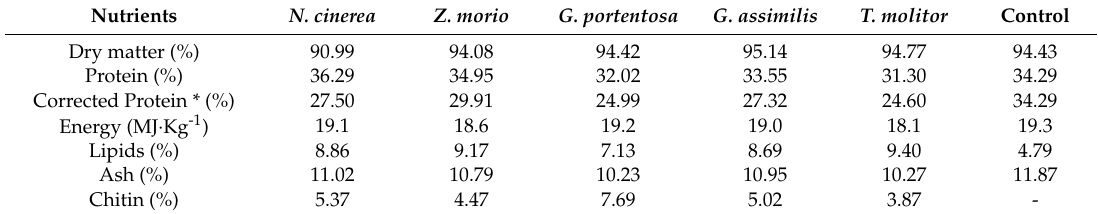
Table 2. Centesimal composition of the experimental diets (dry matter basis).